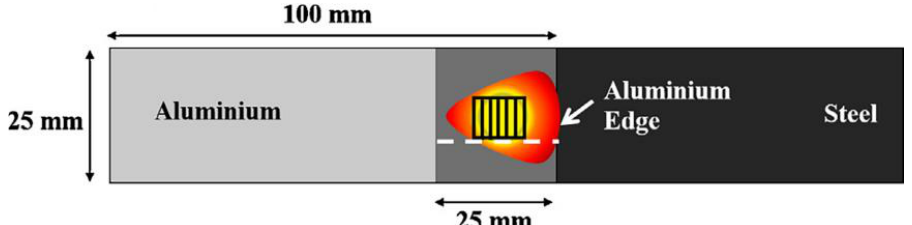
Figure 10. Schematic diagram of temperature field of aluminum side surface in aluminum alloy and galvanized steel [32].